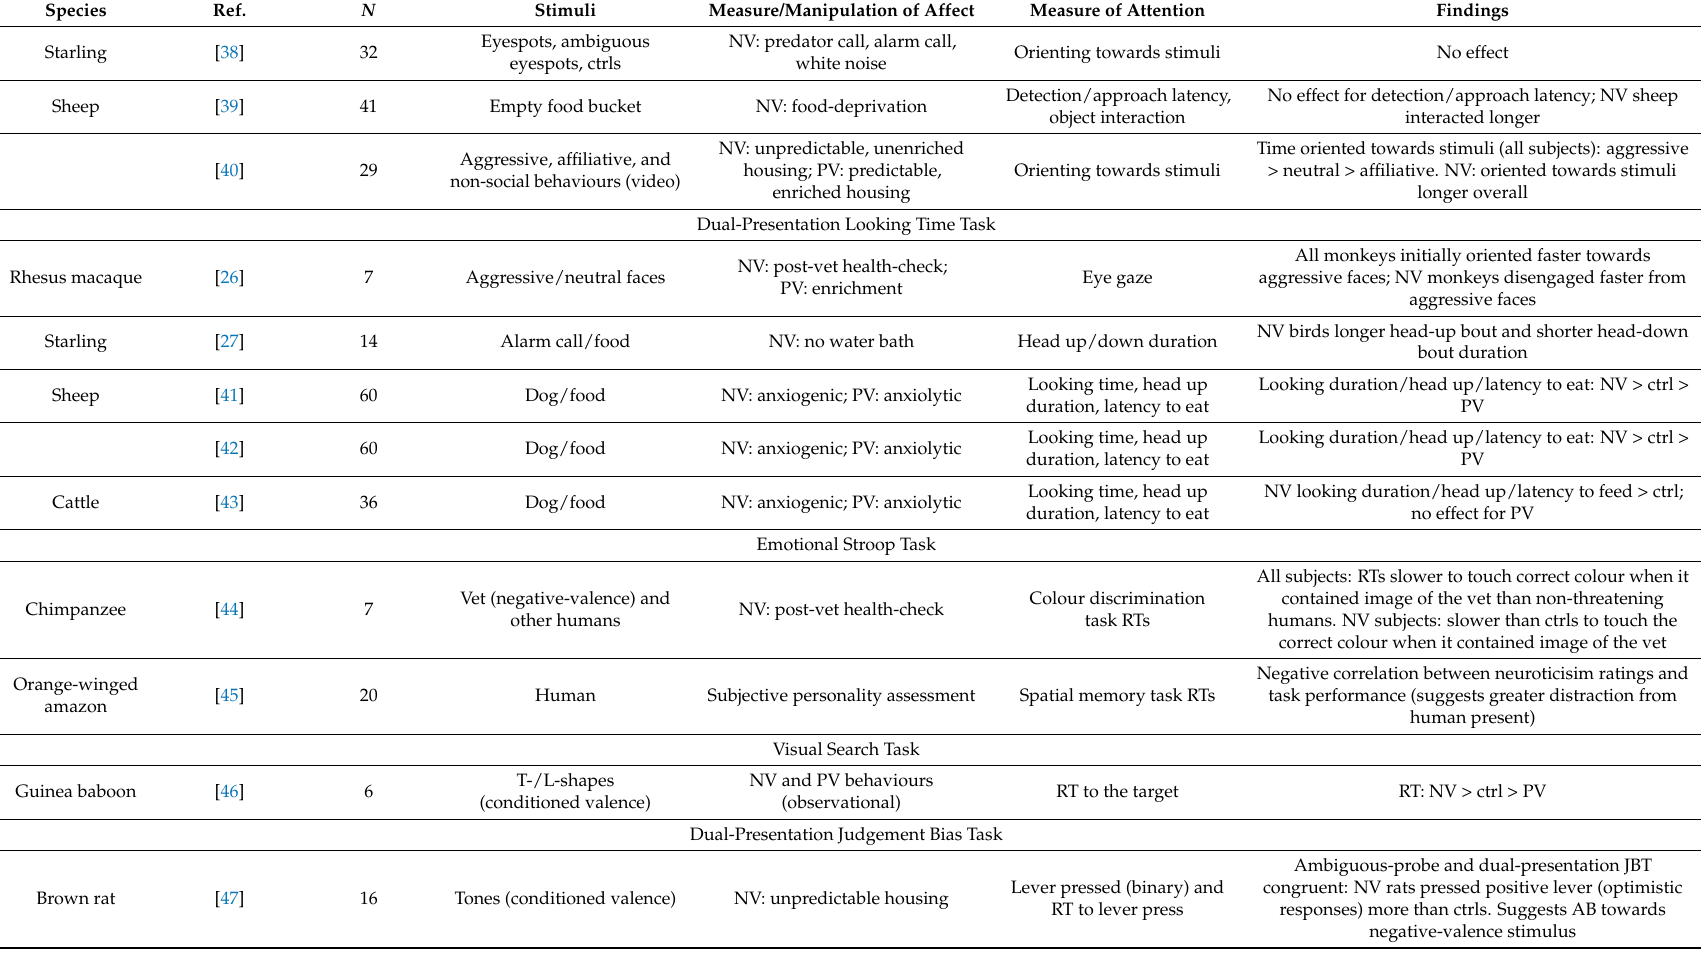
Table 2. Affect-driven attention bias studies on